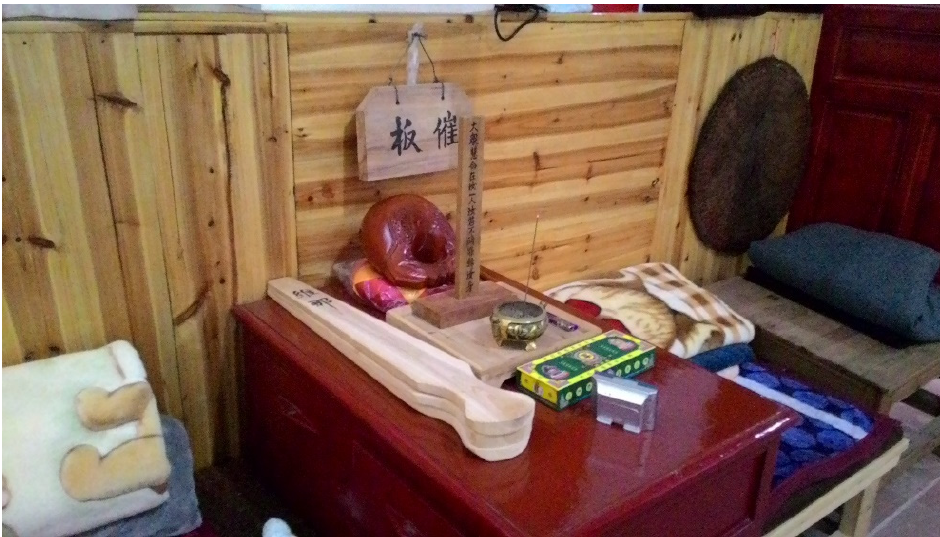
Figure 6. The essential tools of the convener (weino shifu 維那師父 ) of the Chan hall, Baolian Chan Monastery (taken by the author).